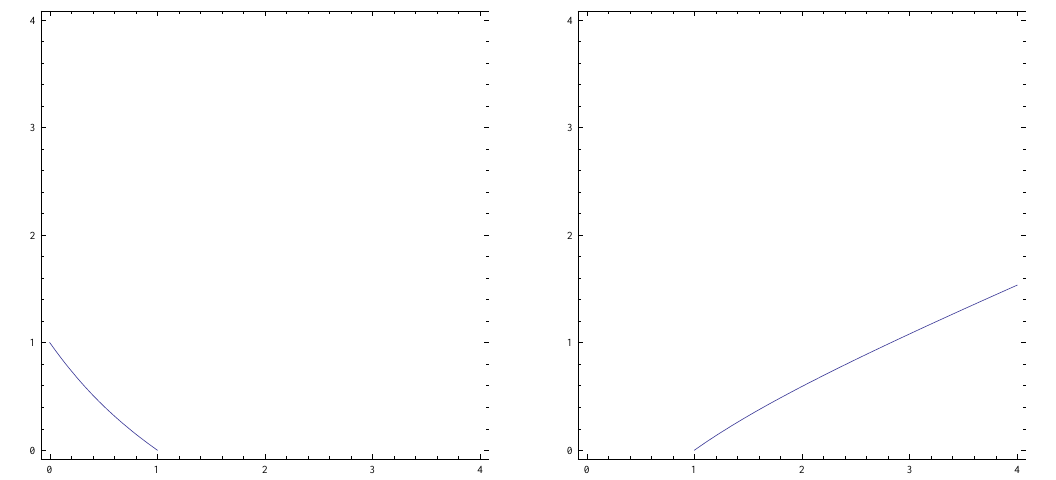
Fig. 4. Resonant region in the | l | 1 , | l | 2 plane for r = 0 . 5. Left: both l 1 , 2 negative. Right: negative l 1 and positive l 2 . Resonant wavenumbers are situated above the displayed limiting curve on the left panel, and beneath the limiting curve on the right panel. Horizontal (vertical) axis: | l | ( | l | ). With growing c + (growing r ) the non-resonant region on the left panel shrinks, keeping the same form, while on the right panel it 1 2 c − is the resonant region which is getting more and more